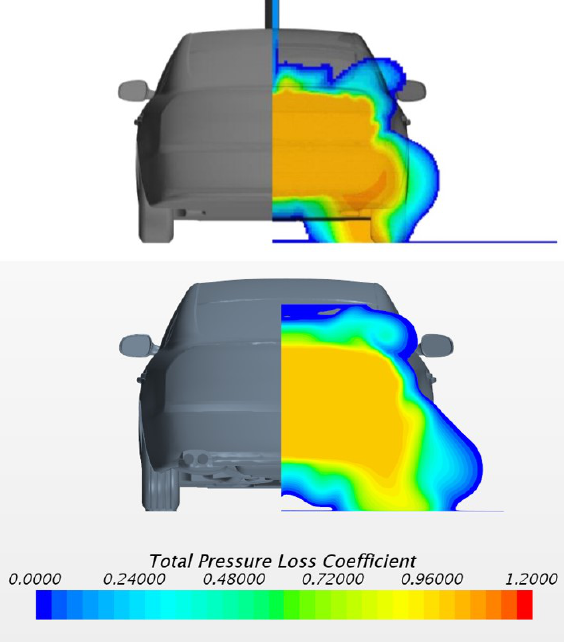
Figure 14. Comparison of wake structure between the RANS predictions from Soares et al. [19] ( top ) and the current CFD ( bottom ) at x / L =